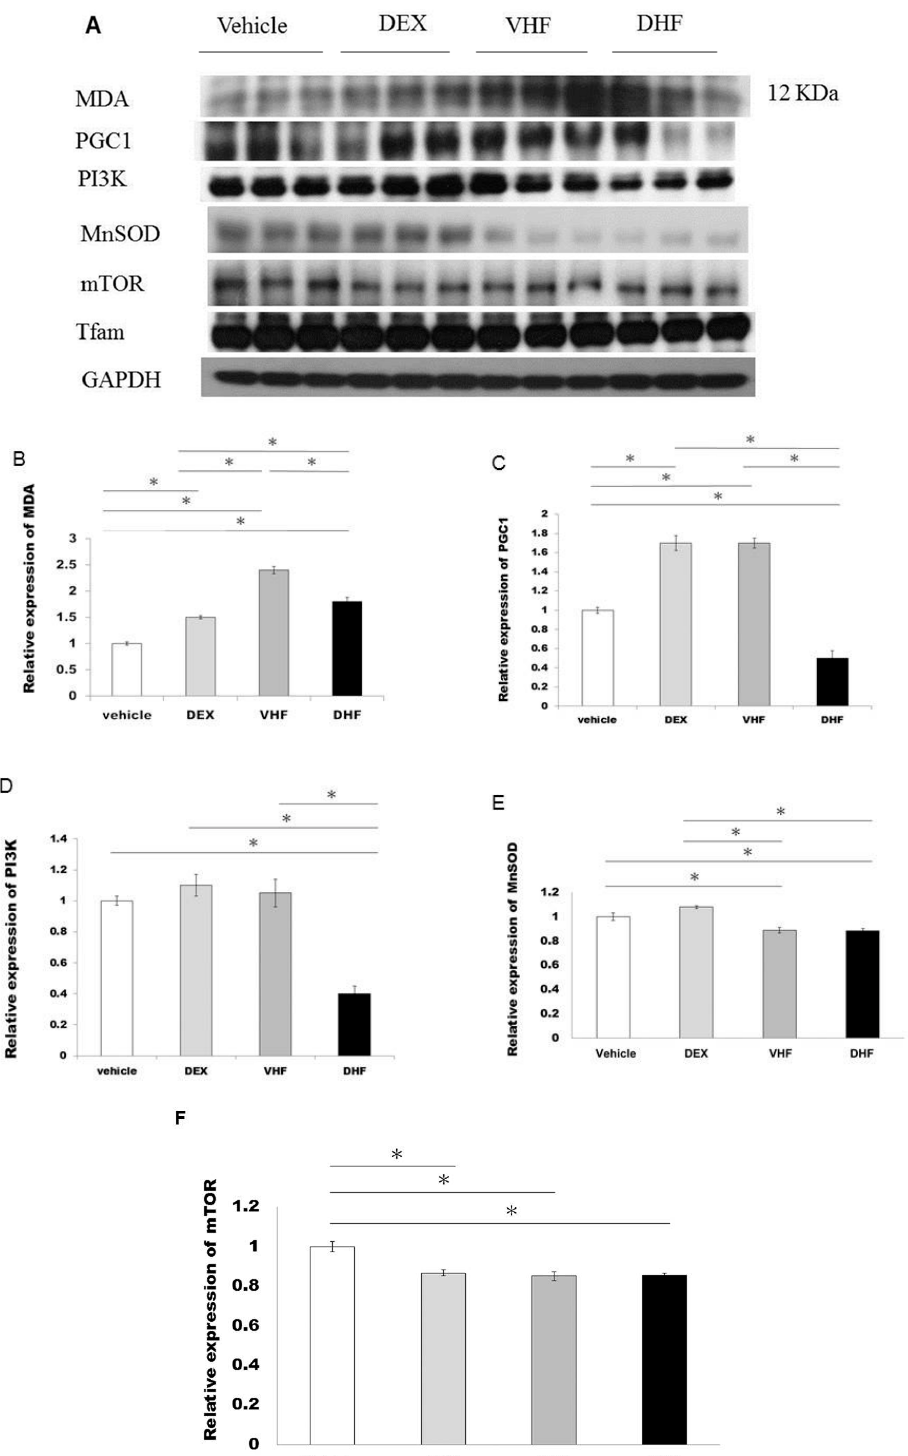
Figure 4. ( A , B , C , D ) Increased malondialdehyde (MDA) protein expression and decreased PGC1, PI3K expression were seen in the DHF treated group than in vehicle treated group, VHF treated group and DEX treated group. ( E ) Lower antioxidant MnSOD was found in the DHF treated group than in the vehicle treated group and DEX treated group. ( F ) There was no significant difference of mTOR among the four groups. All the results represent mean ˘ standard error of six animals, * p < 0.05. The letters above each represented different groups with DEX representing the prenatal steroid treated; VHF treated group, postnatal HF diet group; DHF treated group, prenatal DEX exposure plus postnatal HF diet